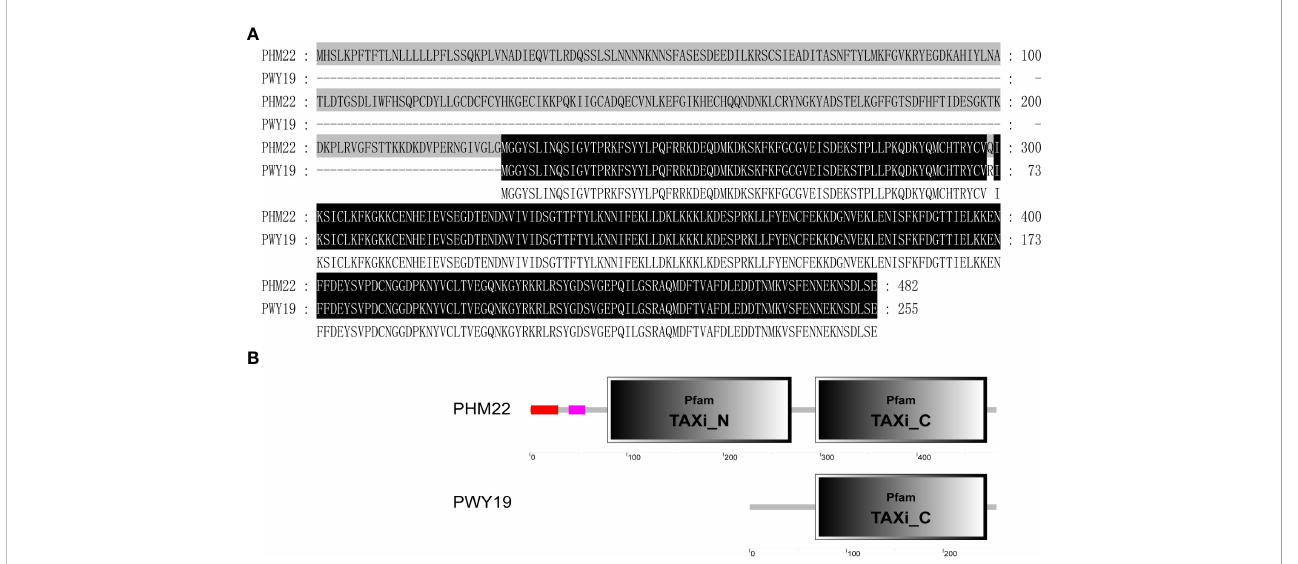
FIGURE 6 Variation of deduced protein of PsXI. (A) Alignment of the deduced protein sequences encoded by PsXI in PWY19 and PHM22. (B) Domain architecture analysis of PsXI in PWY19 and